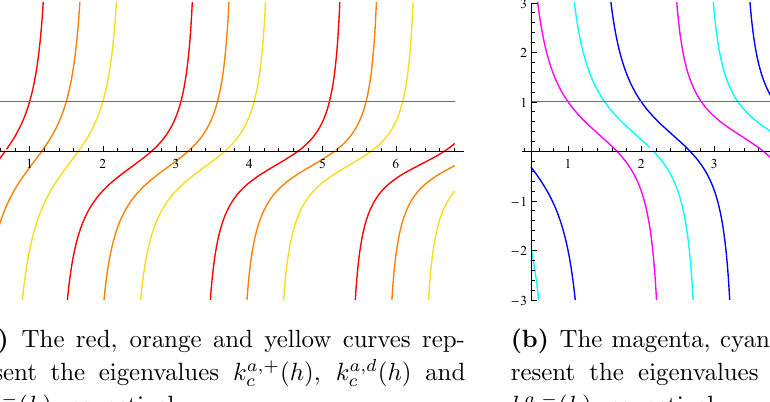
( h ) respectively. Figure 3. A plot of the eigenvalues for the q = 3 model. Each (cid:12)gure illustrates one tower of N = 2 supermultiplets. Their intersects with the horizontal k = 1 line give the dimensions of operators running in the OPE